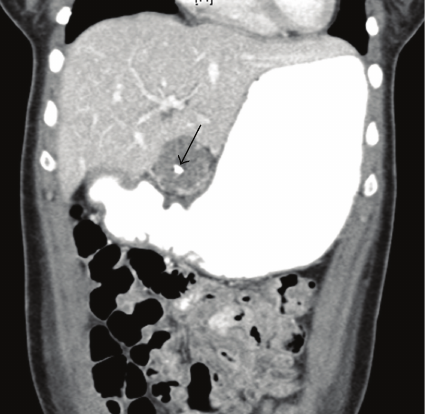
Figure 1: Serous cystadenoma with central scar (arrow) on abdom- inal CT.